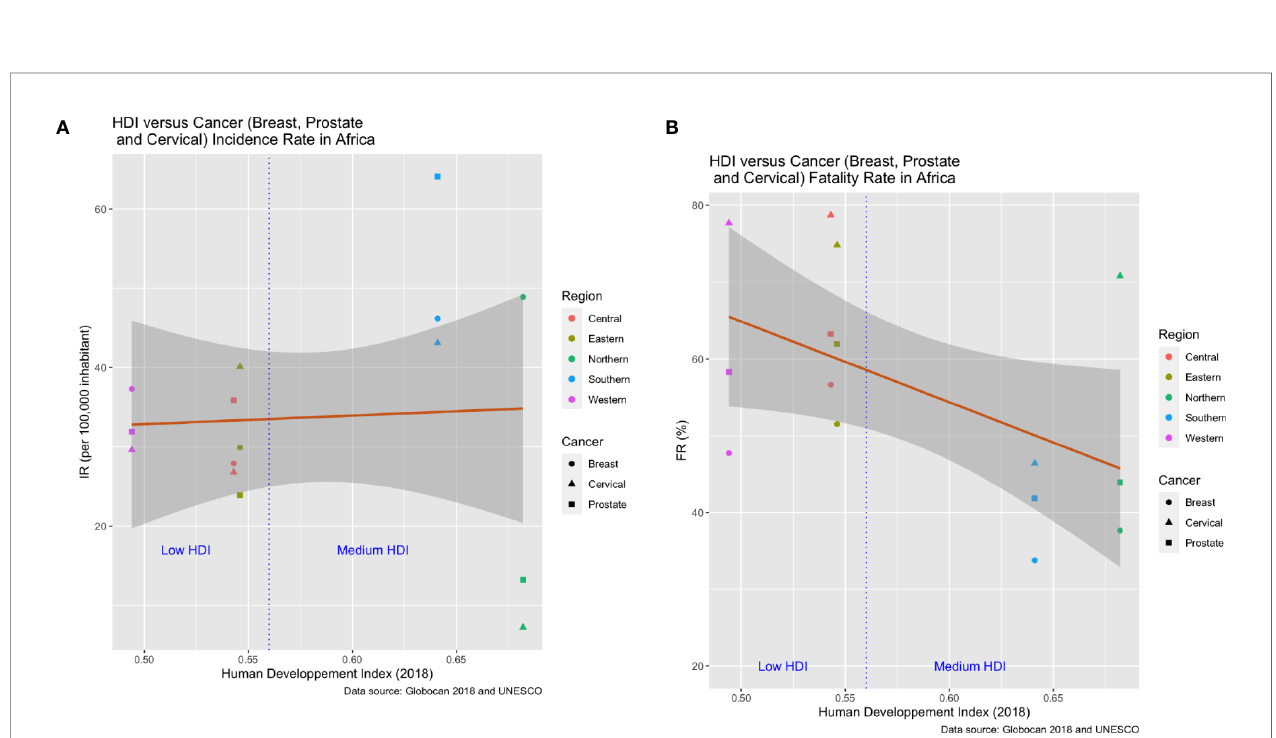
FIGURE 12 | Association between human development index (HDI) and cancer incidence and fatality rates for the fi ve African regions in 2018. The data include fi fteen points per graph resulting from three cancer types (breast, prostate and cervical) per region. (A) The relationship between HDI and cancer incidence rates is not signi fi cant and shows no trends other than higher variance among the cancer types for the two regions (Northern and Southern Africa) with the highest HDI. (B) Cancer fatality rates decline signi fi cantly with HDI for the three most frequent cancer